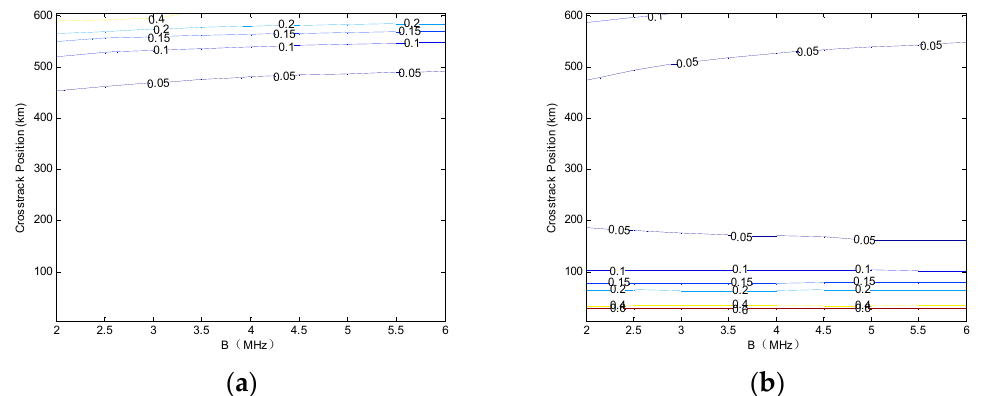
Figure 20. Surface current velocity components Std with bandwidths for a wind speed of 7 m/s and a wind direction of 90°: ( a ) along-track direction; ( b ) cross-track direction. Table 11. Current field effective swaths (current velocity Std of 0.05 m/s) with different bandwidths.